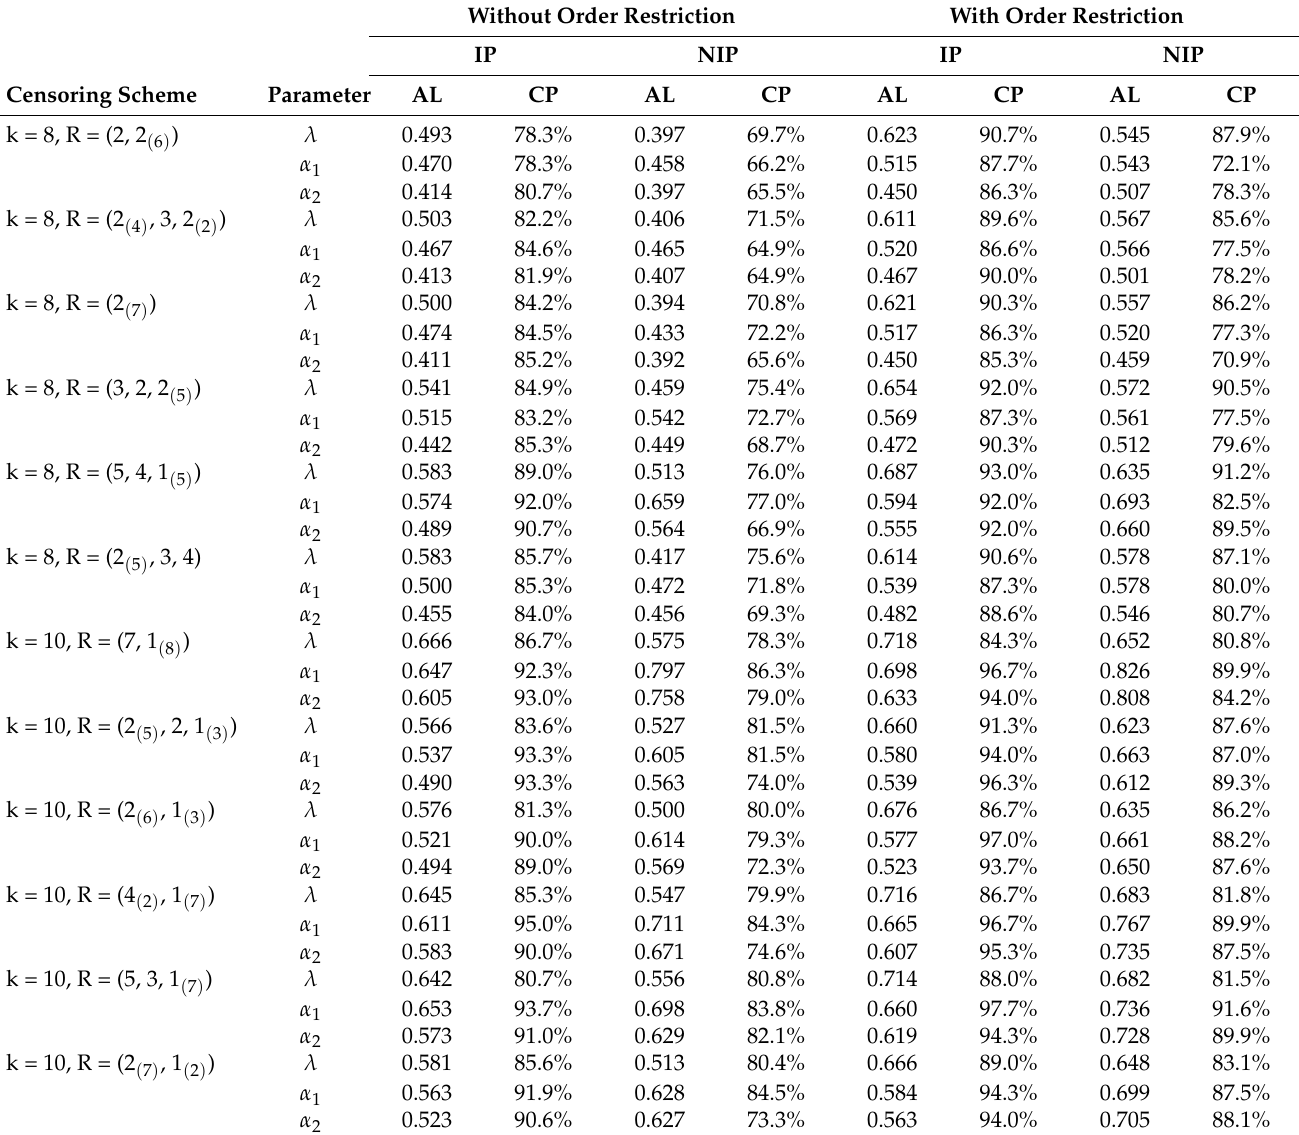
Table 8. CPs and ALs of 95% HPD credible interval of the model parameters with λ = 0.5, α 1 = 0.4, and α 2 = 0.3 based on different